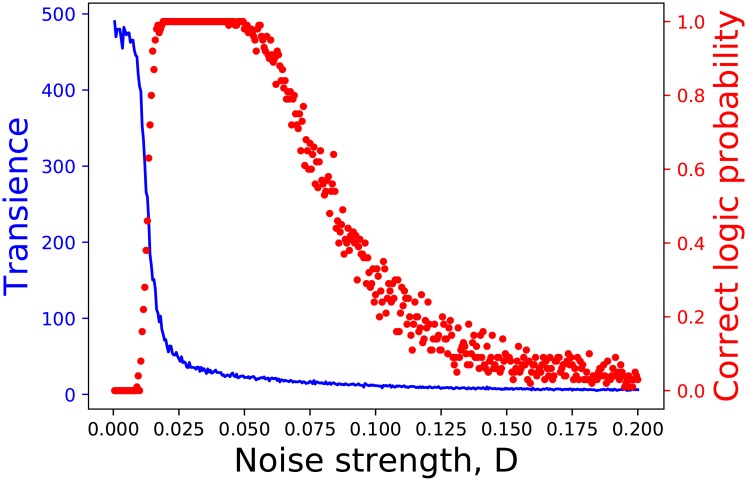
Transience (averaged over a random stream of inputs) as a function of noise strength.Here transience is estimated from numerical simulations, and is the time taken to reach the barrier from a well, when the input switches necessitate a change in the output. It is shown in terms of the scaled time in Eq 3, where 1 unit is 0.0000134 sec. The system parameters are those given in Fig 10.